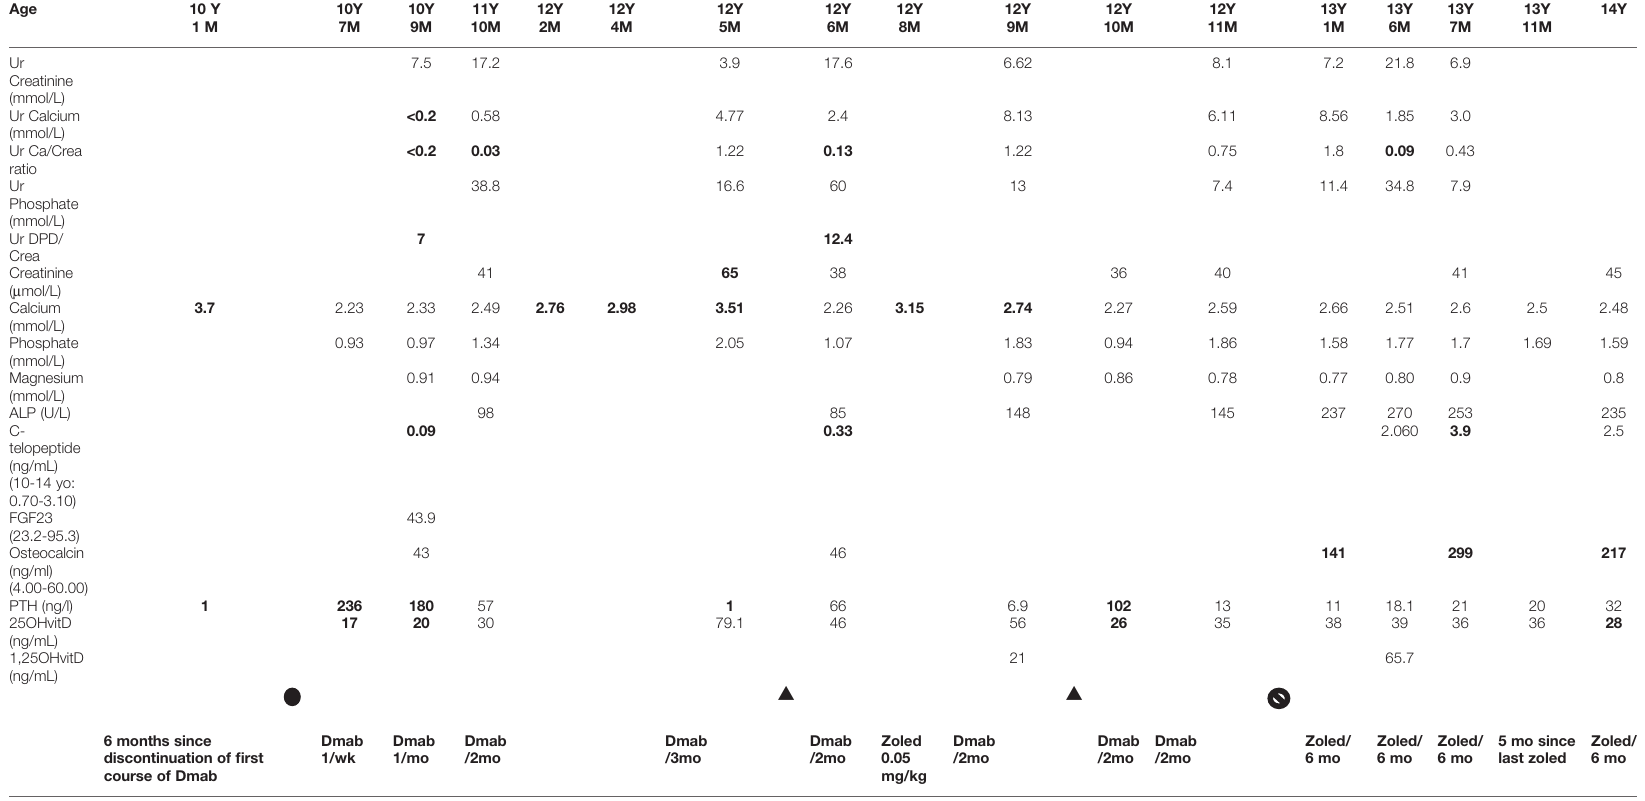
TABLE 1 | Blood exams results during denosumab